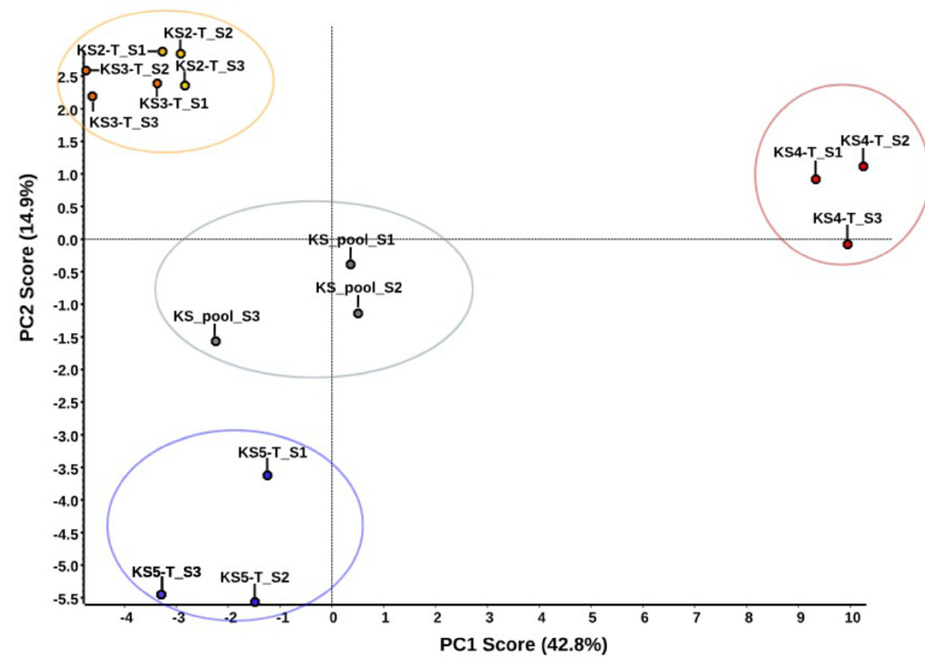
Figure 4. PCA analysis of four sialoliths used in quantitative analysis. Each sample of a tested sialolith was individually compared with the combined four samples (pool). In all investigated statistical comparisons, we detected 34 differential proteins (Table 1). Table 1. Statistically significant sialolith proteins ( p -value < 0.05) qualified based on quantitative analysis as candidates for biomarkers of the formation of salivary glands.